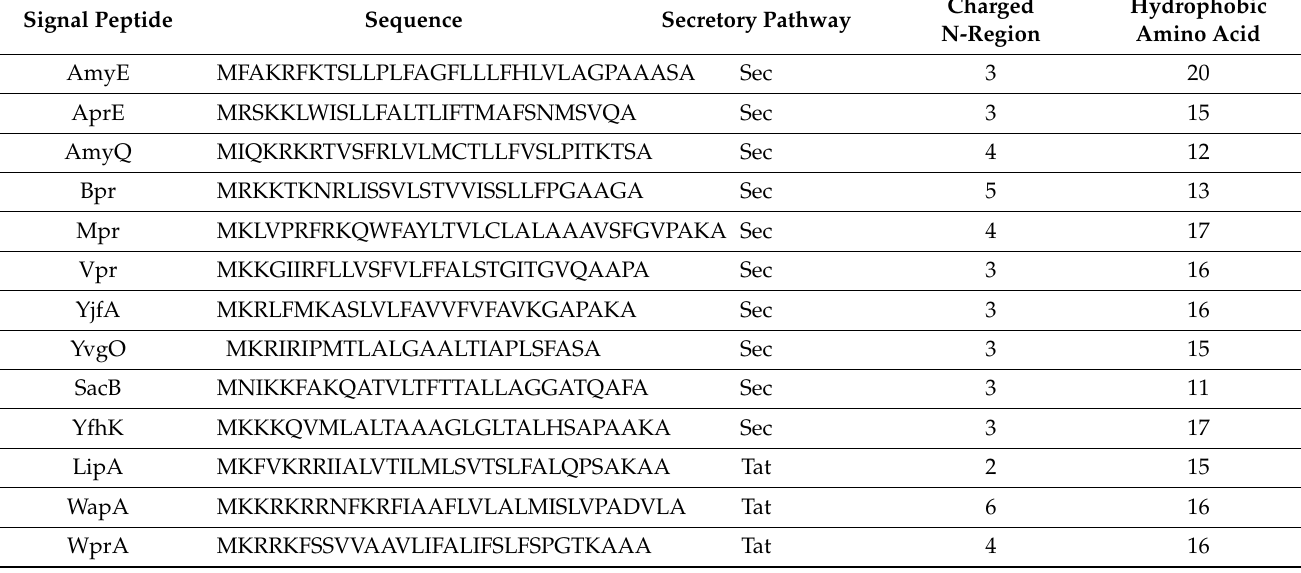
Table 1. Comparison of various signal peptide sequences used for KsLX3-SIase expression. Signal Peptide Sequence Secretory Pathway